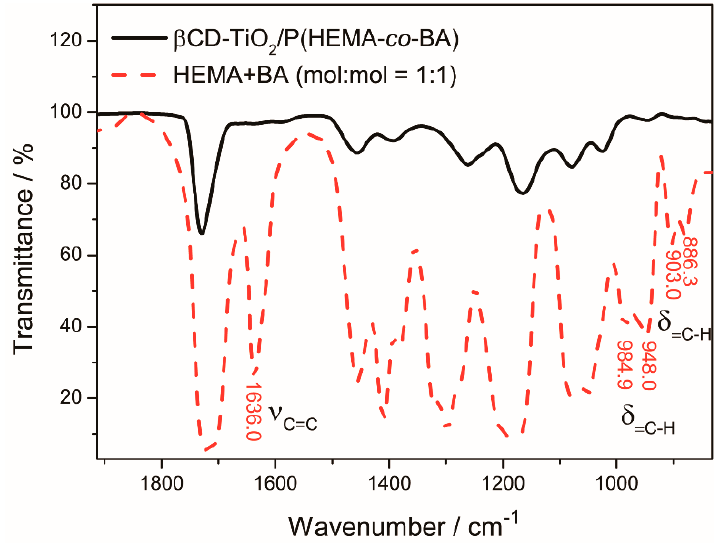
Figure 6. FT-IR spectra of monomer (HEMA + BA) and polymer β -CD-TiO 2 /P(HEMA-co-BA).